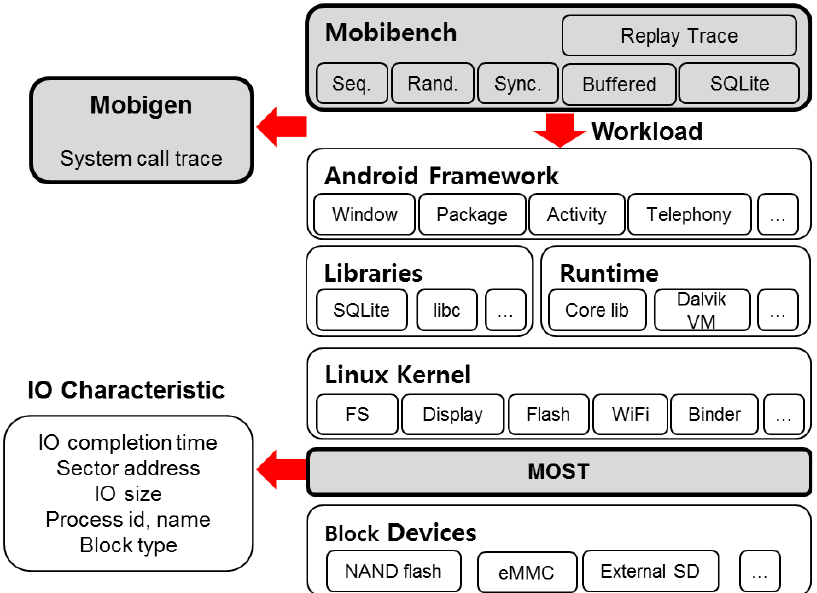
Figure 1. Structure of AndroStep (Mobibench, MOST, and